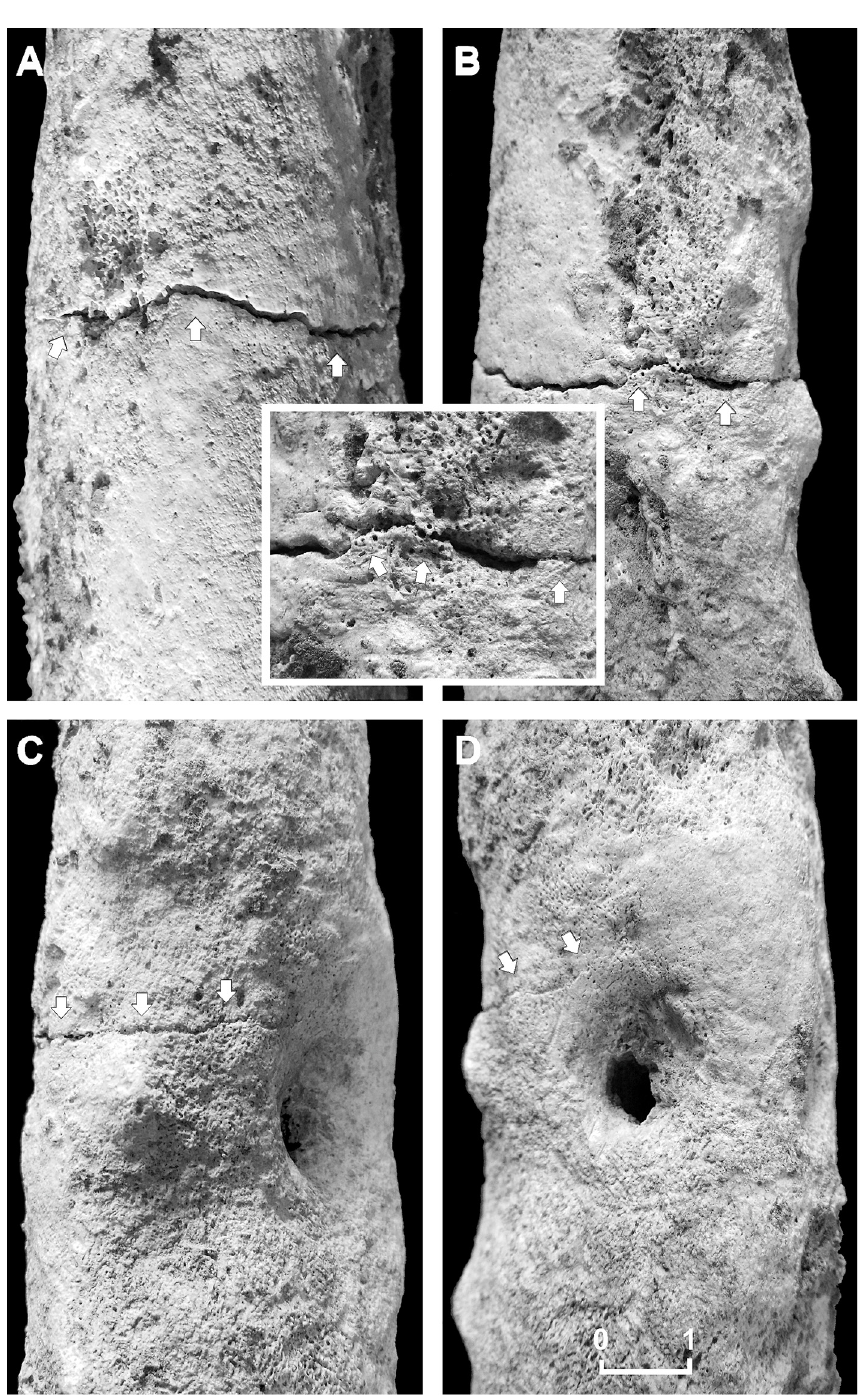
Fig 6. Details of the femoral nonunion fracture. Anterior (A), medial (B), posterior (C) and lateral (D) views of the middle shaft of the right femur showing a transverse simple linear fracture (arrows), characterized by unhealed margins and lack of bone callus regeneration (A-D). Wide cloaca opening, surrounded by reactive bone (D). Detail of few bone bridges (box) on the medial aspect of the lesion, indicative of poor bone repair. Scale bar equals 1